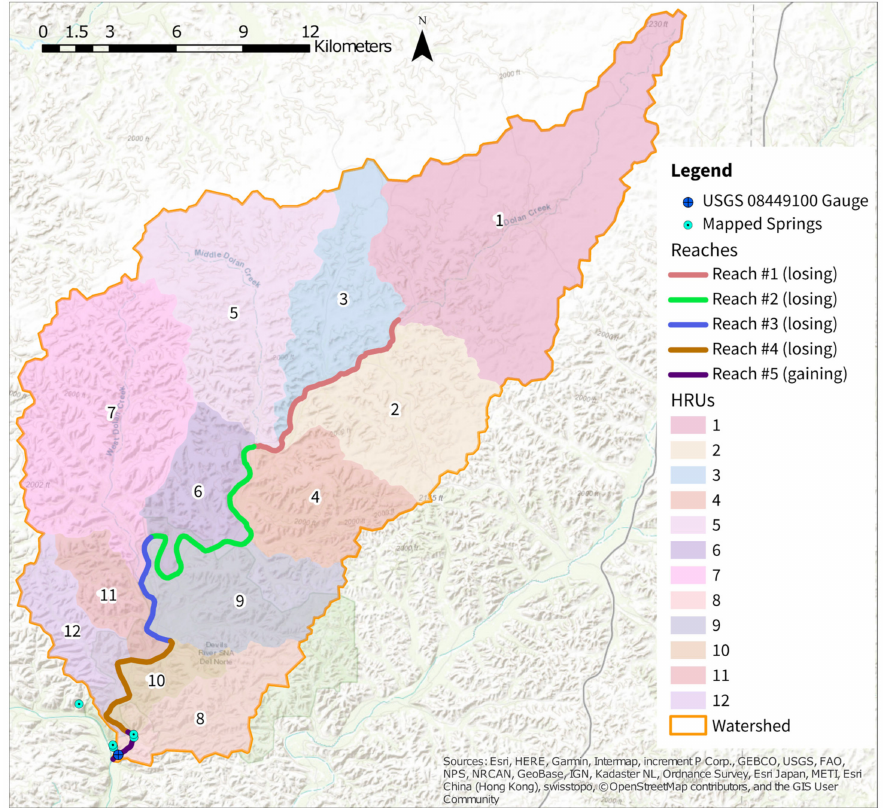
Figure 3. Site watershed Hydrological Simulation Program—FORTRAN (HSPF) model configuration. Each hydrologic response unit (HRU) is composed of pervious (PERLND) and impervious (IM- PLND) portions. Stream reaches are represented with well-mixed reservoir structures, or RCHRES components. Adapted from Martin [19] CC BY